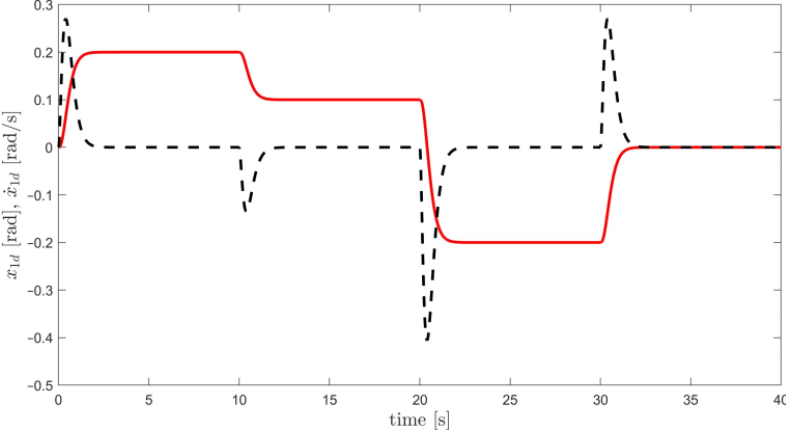
Figure 12. The desired trajectory 𝑥 1𝑑 (solid red line) and derivative 𝑥̇ 1𝑑 (dashed black line). Figure 13 demonstrates the tracking errors E 1 = x d − ˆ x 1 and E 2 = x 2 d − ˆ x 2 for . − x x different values of control parameters k 1 , . . . , k 4 . The tracking errors x 1 d − x 1 and 2 . 1 d plots are presented. In the interval [ 10, 40 ][ s ] , both, the mean and the extremal quasi-steady state error for k 1 = k 2 = k 3 = k 4 = 15 (solid red line in Figure 14) are evidently smaller